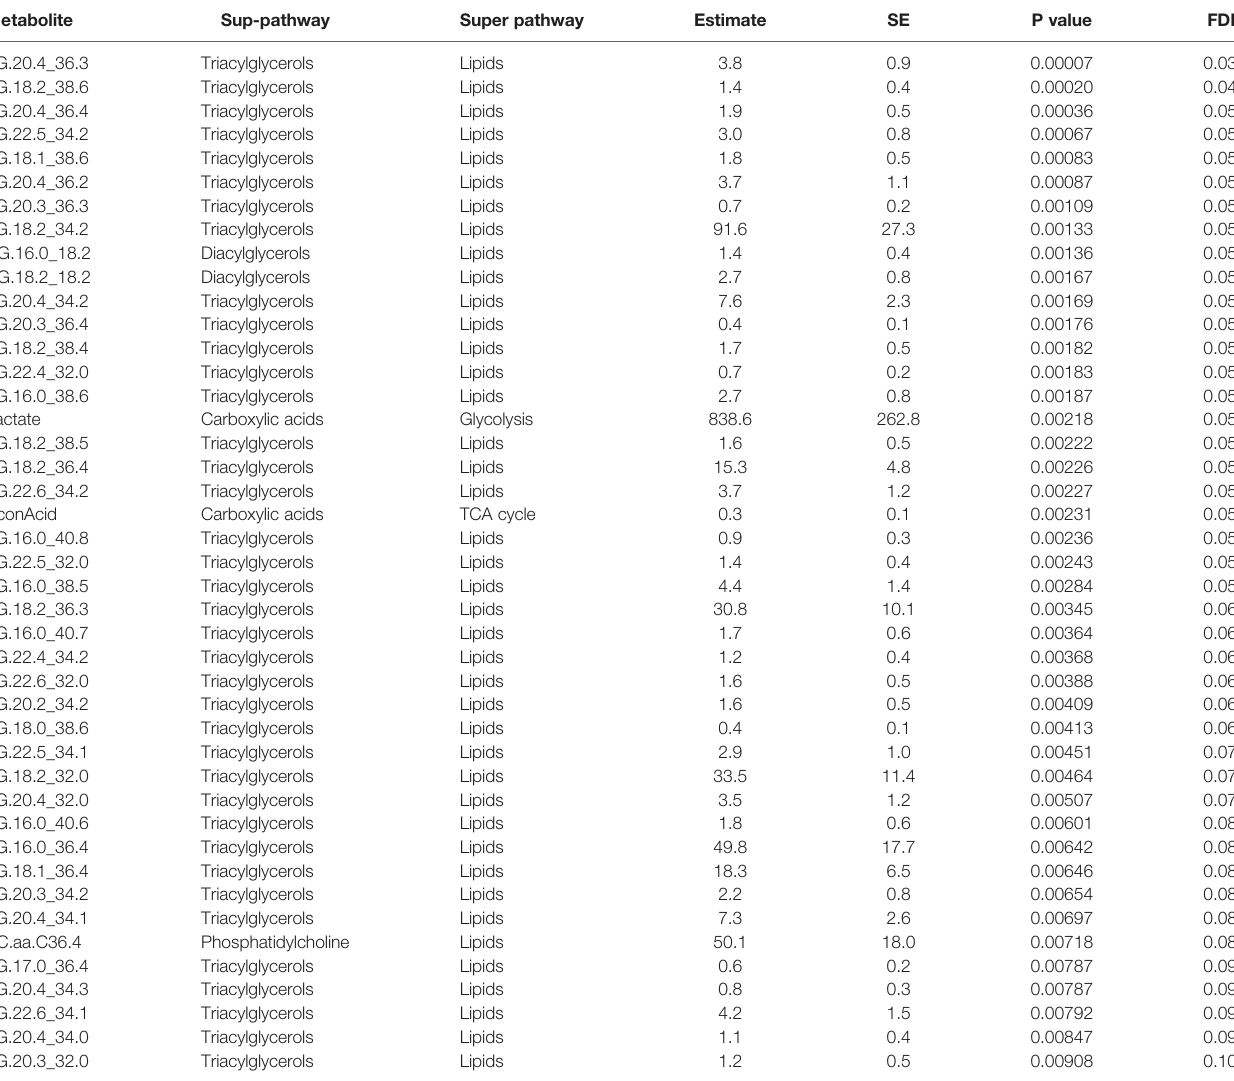
TABLE 2 | Metabolites differentiating controls from PCOS women in their second trimester.